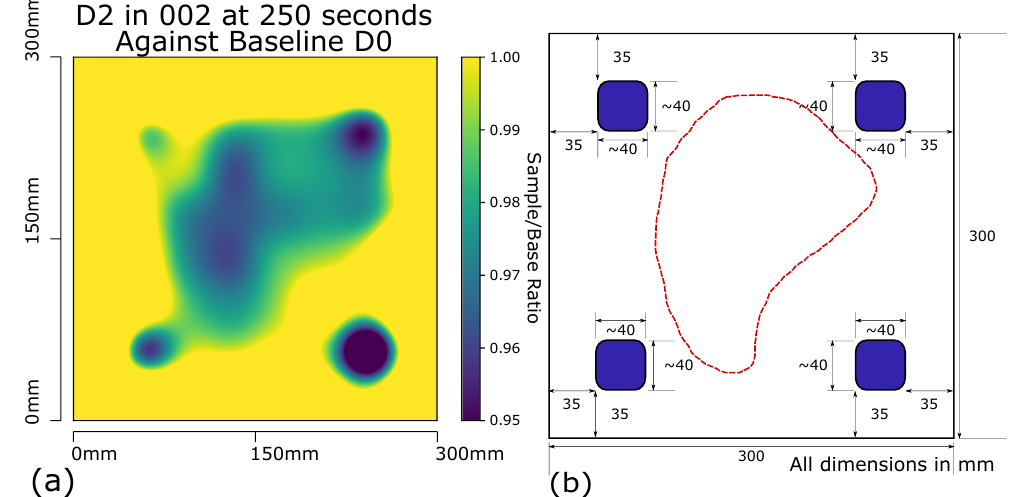
Figure 10. ( a ) Panel D2 at 250 s with Gaussian interpolation applied to RTD array captured data. Each probe compared against corresponding baseline probe on D0 sample at same time and temperature. Max scale set to 1, min scale set to 0.95. ( b ) Panel D2 defect locations. Impact damage blue, induced dis-bond between core and laminate area red